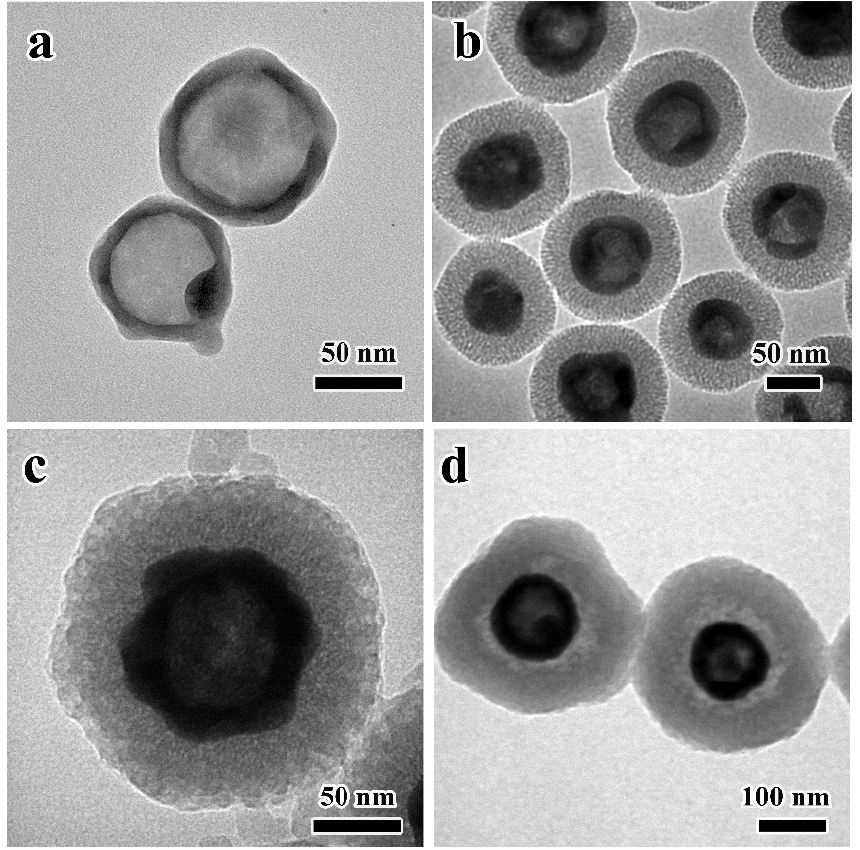
Figure 2. TEM images of HAg 2 S ( a ), HAg 2 S@mSiO 2 ( b ), HAg 2 S@mSiO 2 @MPDA ( c ), and HAg 2 S@HMPDA/PEI ( d ).